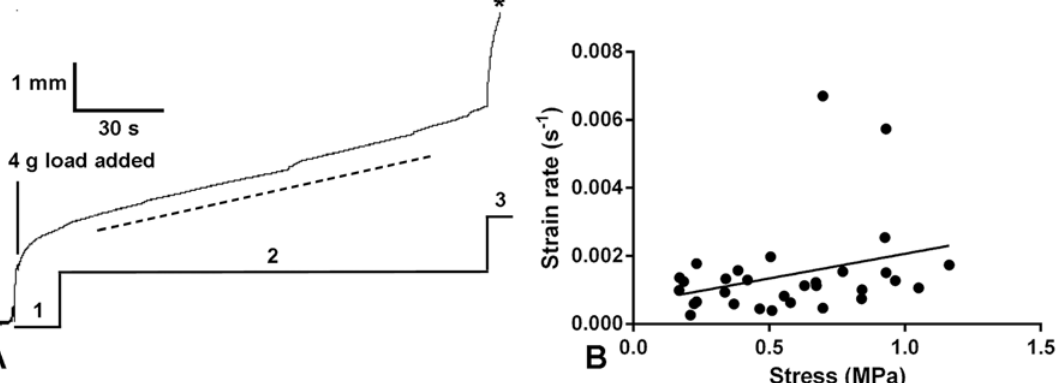
Fig 3. Creep behaviour of P . lividus CDs. (A) Recording of a representative creep curve, showing the primary (1), secondary (2) and tertiary (3) phases, the last leading to rupture (asterisk). The dashed line indicates the slope of the secondary phase, from which the viscosity was calculated. (B) Relationship between strain rate during the secondary phase and stress. The best-fit line generated by linear regression is included ( y = 0.0015 x + 0.0006; Spearman r = 0.3076; P = 0.0924).